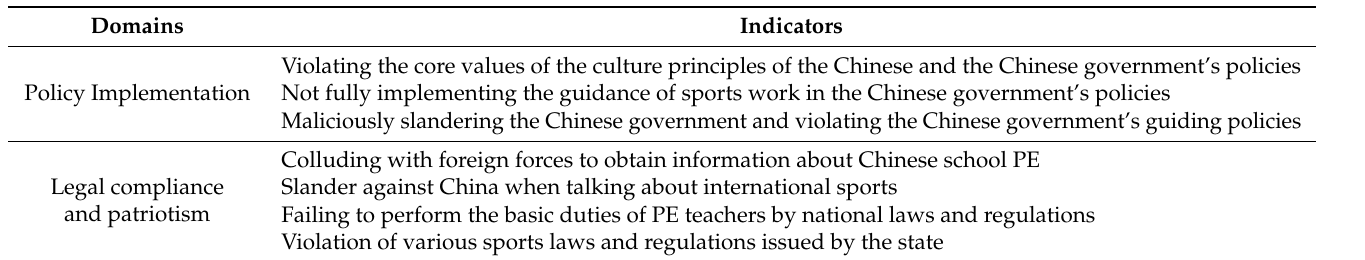
Table A3. The overall framework of the evaluation criteria of